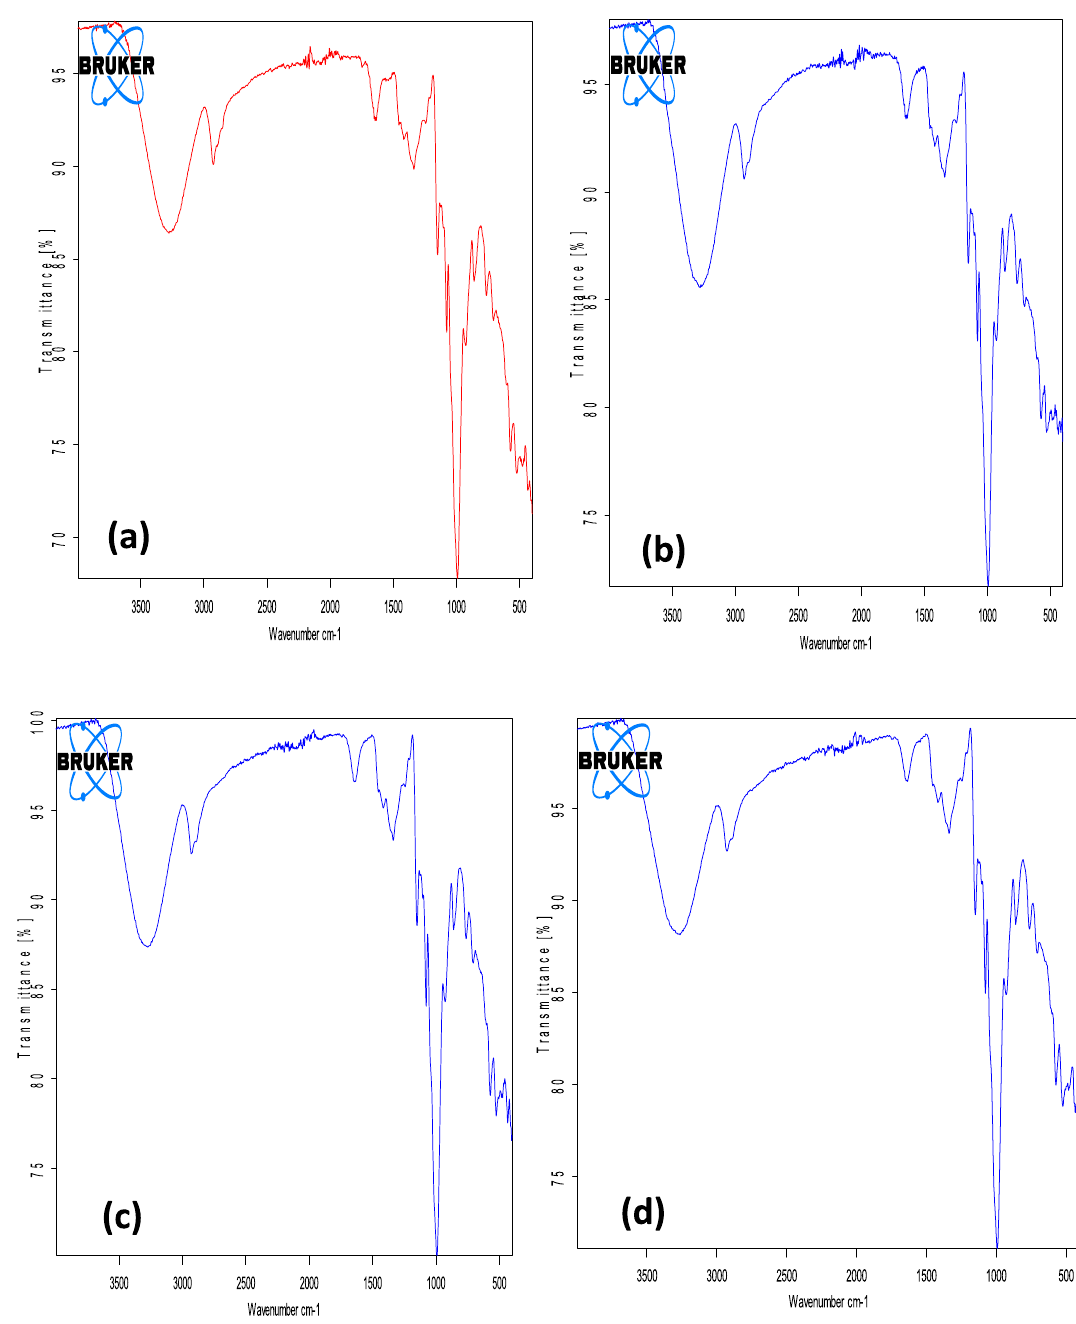
Figure 4. FTIR spectra of Bambara groundnut starch (BGS). ( a ) unmodified BGS; ( b ) Heat moisture treated at 15% moisture content Bambara groundnut starch (HMT 15-BGS); ( c ) HMT 25-BGS; and ( d ) HMT